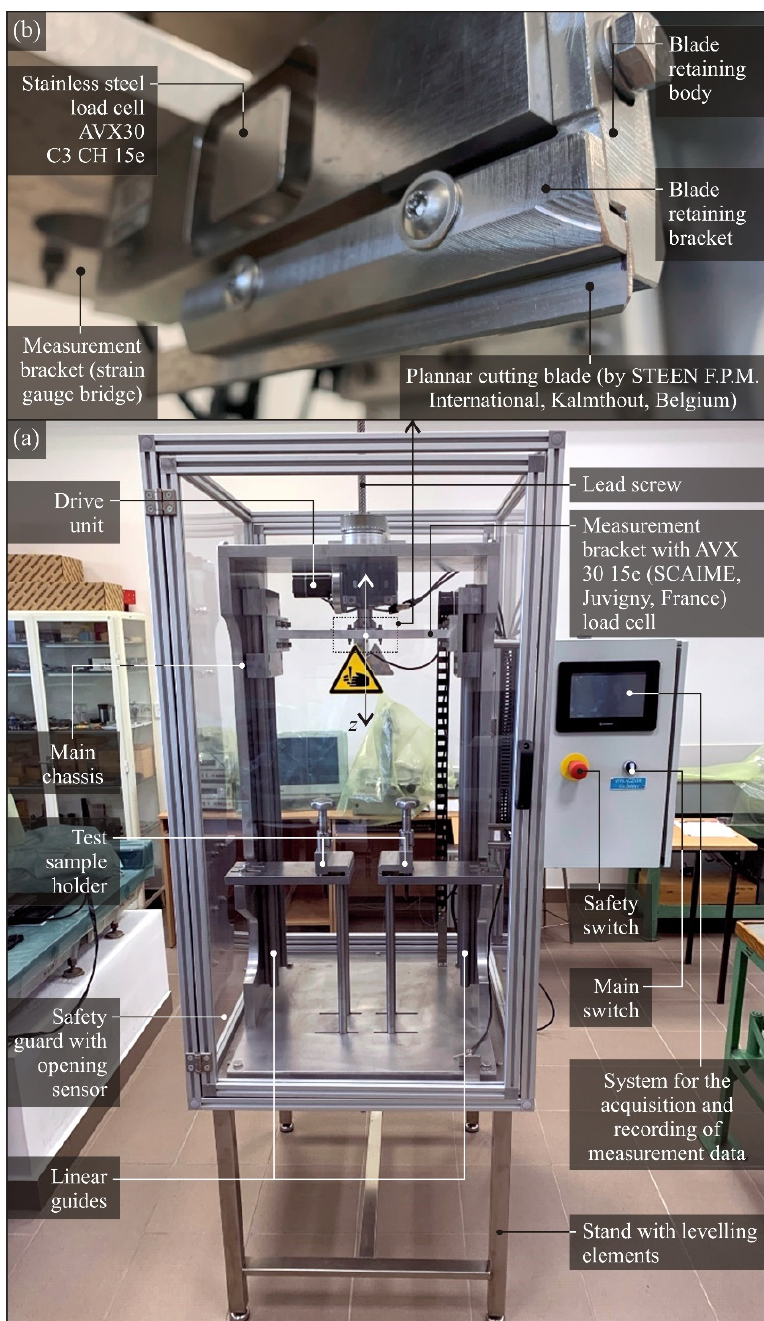
Figure 2. General view of the cutting force evaluation test stand with the most important functional modules indicated ( a ) and a view of fixing method of the blade to be assessed ( b ).